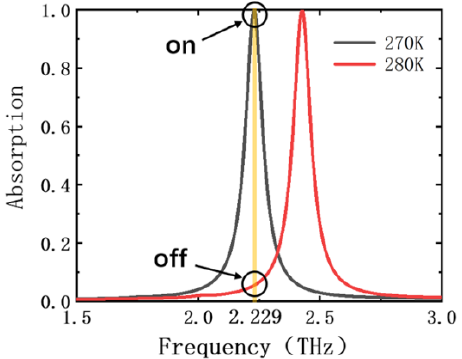
11 of 14 Figure 9. ( a ) Absorbance spectra of the designed PMMA based on added graphene layer with dif- ferent temperature T, ( b ) the simulated resonance frequencies (black squares), and the fitting curve (solid red line) as a function of external temperature T. 3.6. Thermal Switch Furthermore, the proposed PMMA can not only be applied as a temperature sensor but also as a thermal switch. Considering 270 K and 280 K as examples, it can be observed from Figure 10 that at 2.229 THz, the corresponding absorption rate at 270 K is 99.9%, whereas the corresponding absorption rate at 280 K is approximately 5%. Similarly, at 2.426 THz, the corresponding absorption rate at 280 K was 99.9%, whereas the correspond- ing absorption rate at 270 K was approximately 5%. We can define 2.229 THz as the stand- ard point. When the absorption rate reaches 99%, it is defined as “on” , otherwise, it is